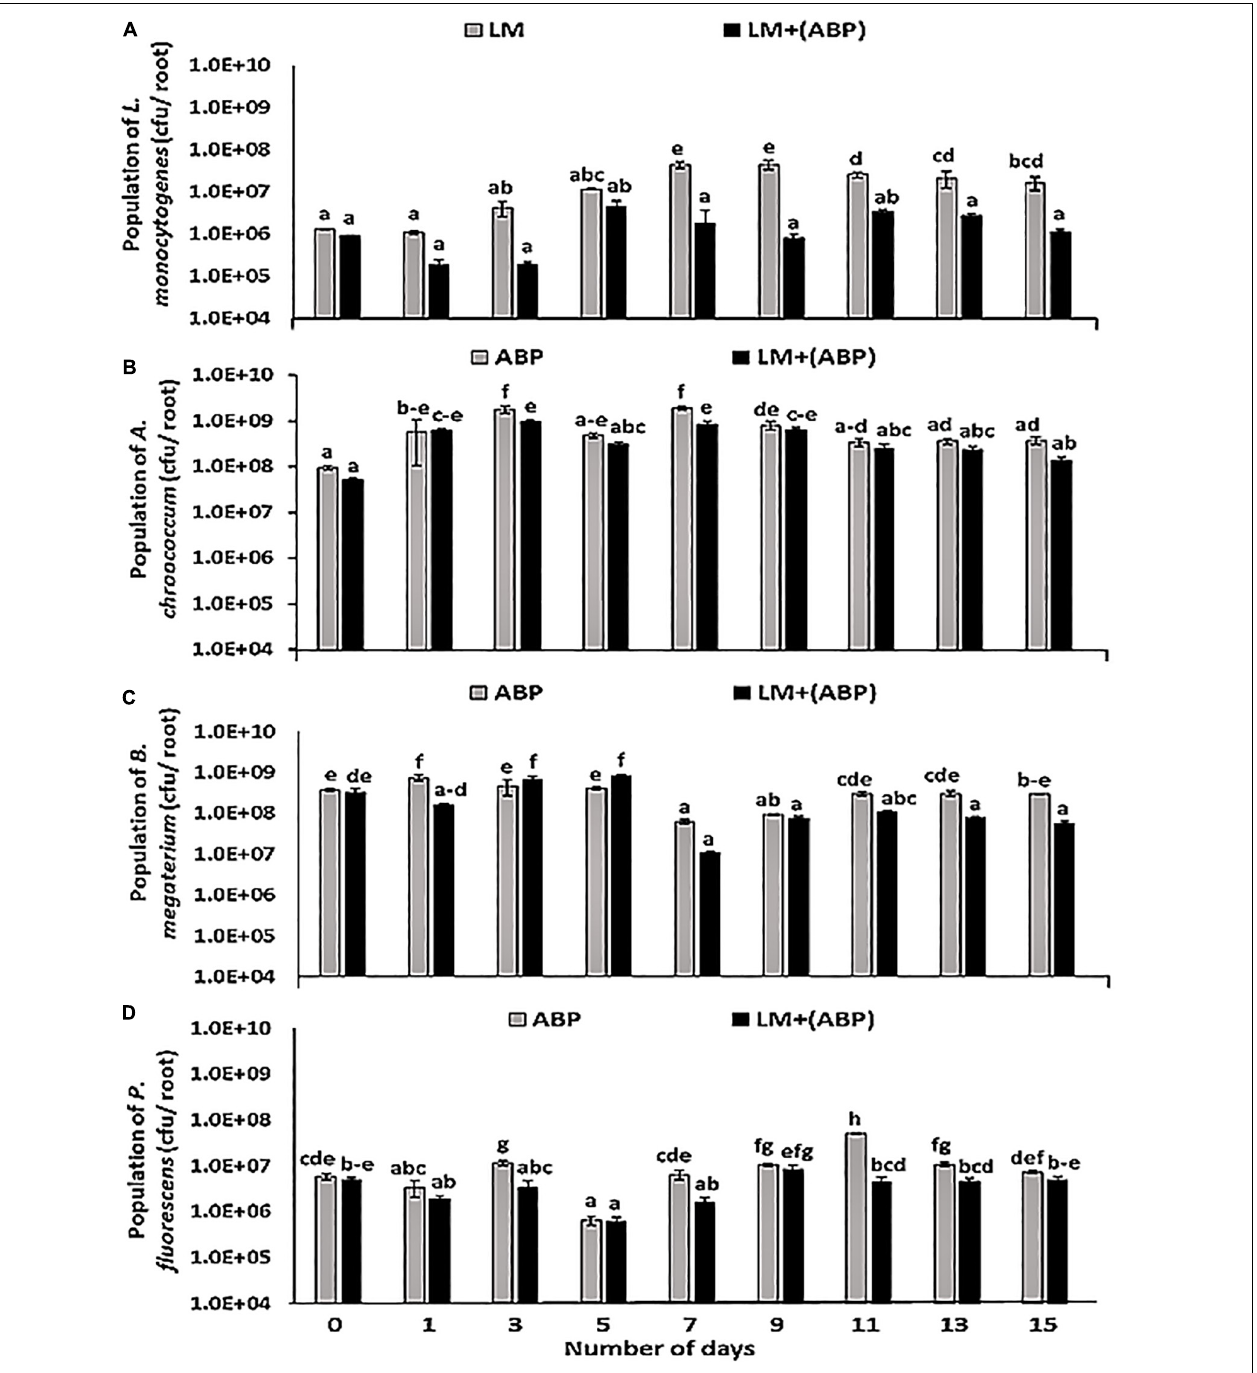
FIGURE 1 | Population dynamics of (A) Listeria monocytogenes , (B) Azotobacter chroococcum , (C) Bacillus megaterium , and (D) Pseudomonas fluorescens during incubation in the Cajanus cajan plant model for 15 days, assayed by plating samples on TSA containing rifampicin, streptomycin, kanamycin, and ampicillin, respectively. Significantly different values ( p < 0.05) between different treatments and time points are marked by lower case letters. Standard deviation ( n = 3) is represented by error bars.